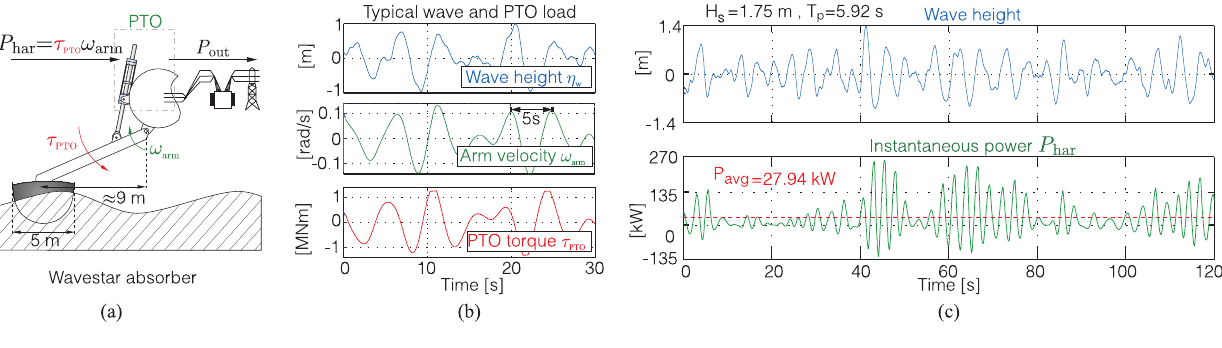
Figure 3. ( a ) the definition of Power Take-Off (PTO) system; ( b – d ), different fluid power based transmission in PTO